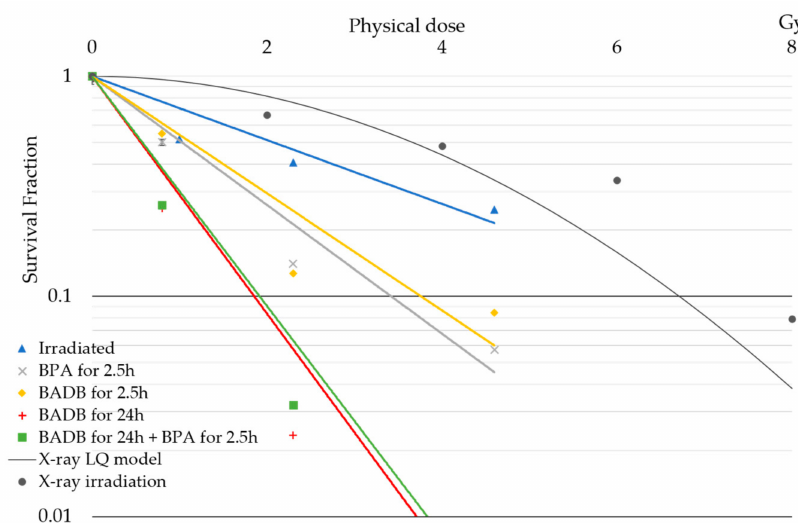
Figure 4. Clonogenic survival lines after neutron irradiation and photon irradiation fitted to the linear–quadratic (LQ) model for F98 glioma cells. Surviving fractions against physical doses were plotted to surviving approximate lines in each boron compound group. The error bars indicate standard